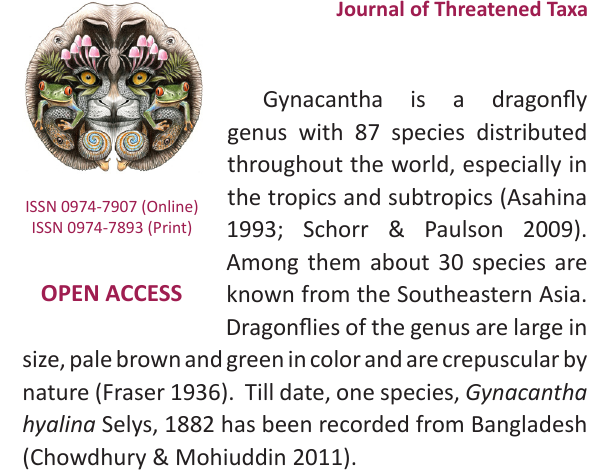
veins brownish. Brown rays present in the subcostal and cubital spaces of forewing and hindwing. Pterostigma pale brown to golden, three millimeters in length and covering three to four cells. Discoidal of forewings and hindwings are six-celled and five-celled respectively, basal cell divided into two cells; six nerves traversing hypertrigones of forewings and hindwings. cubitas nerve in forewings, six in the hindwings. Anal loop oval-shaped, consists of 13 cells. Nodal index: 18– 25/25–18 in forewings and 21–18/19–21 in hindwings. First and second abdominal segments swollen, third segment strongly constricted and elongated, segments 8–10 are narrow and cylindrical, color is blackish-brown. Caudal appendages are brownish; the superior long and straight, basal one-fifth is narrow, the next two-fifth is swollen slightly and uniformly and the terminal two-fifth is more broadened. The apical end is sharply pointed and directed